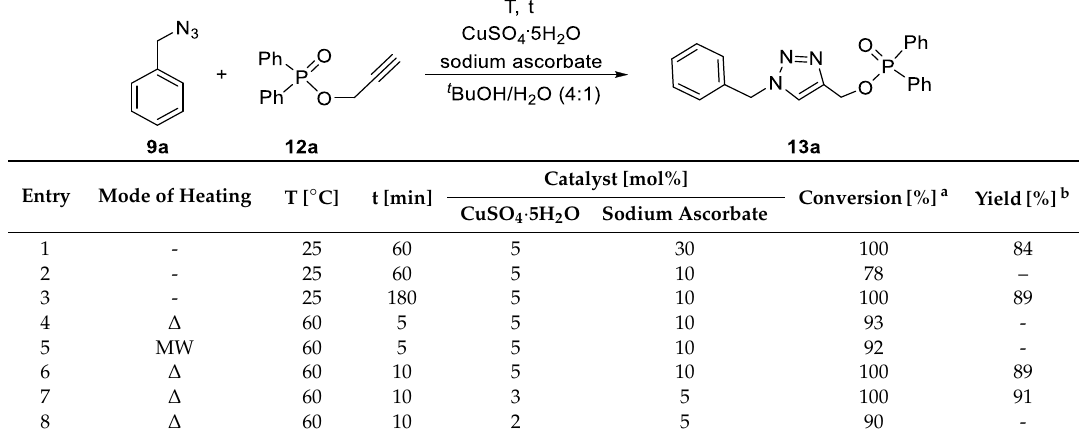
Table 1. Optimization of the reaction of benzyl azide ( 9a ) and propynyl diphenylphosphinate ( 11a ).